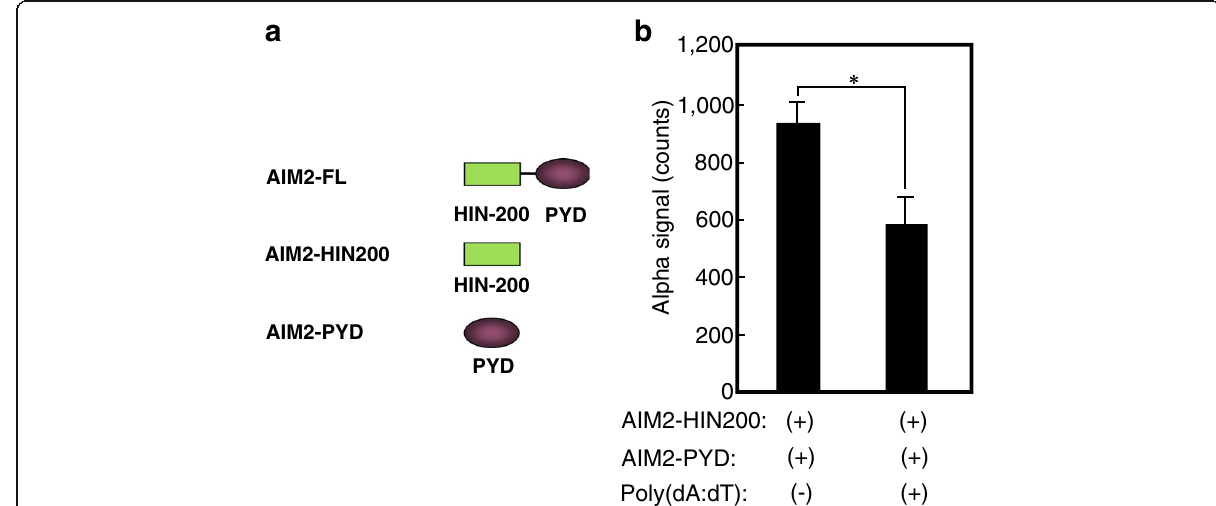
Fig. 2 poly(dA:dT) reduces the amplified luminescent proximity signal between the PYD domain of AIM2 and the HIN-200 domain of AIM2. A schematic representation of full-length AIM2 (AIM2-FL) and its truncated proteins, the HIN200 domain of AIM2 (AIM2-HIN200) and PYD domain of AIM2 (AIM2-PYD). We synthesized two truncated forms of AIM2, AIM2-PYD-FLAG and AIM-HIN-200-Biotin, using a wheat germ cell-free synthesis system ( a ). Synthetic protein – protein interactions were detected by the amplified luminescent proximity homogeneous assay (Alpha). A total of 100 ng of each protein indicated was incubated with 5 μ g/mL anti-FLAG mAb M2, 16.67 μ g/mL protein-A-conjugated Alpha acceptor beads (PerkinElmer, Waltham, MA, USA), and 16.67 μ g/mL streptavidin-conjugated Alpha donor beads (PerkinElmer, Waltham, MA, USA) for 24 h with or without 5 mg/mL poly(dA:dT) (Invivogen, San Diego, CA, USA). Responses (counts) were measured using EnSpire ™ Multimode Plate Reader (PerkinElmer, Waltham, MA, USA). The results are given as means±standard deviation from triplicate wells. Asterisk indicates significance ( p < 0.01) ( b )